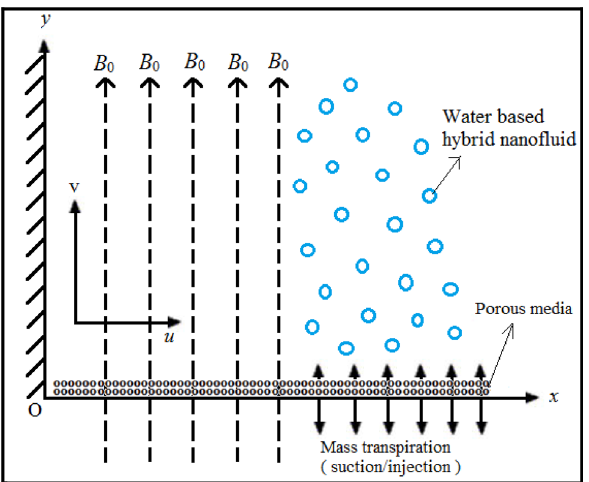
Figure 1. Schematic of reactive MHD nanofluid coating boundary layer flow in porous